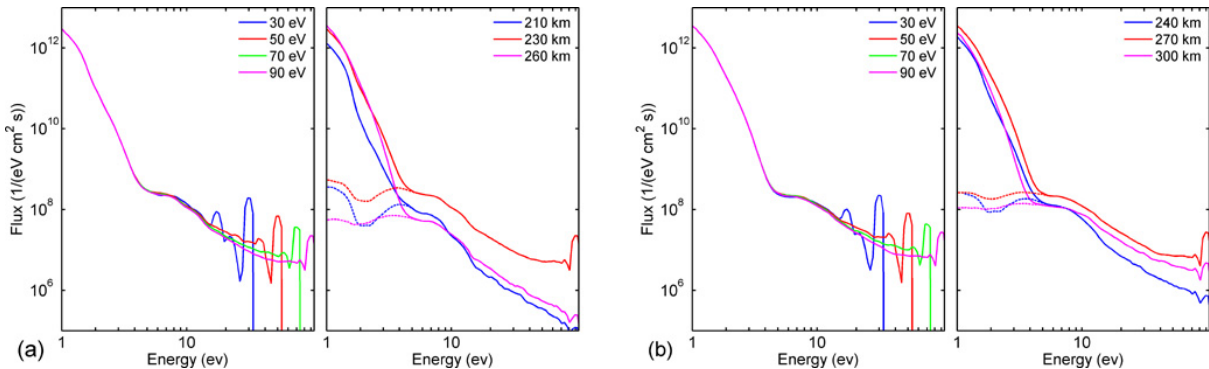
Fig. 6. (a) The energy dependence of the electron differential flux for the heating pulse at 18:12UT. Left: The differential fluxes for various energies of the accelerated electrons at the electron acceleration altitude (230km). Right: The electron differential fluxes at various altitudes calculated for the acceleration energy of 90eV. The dashed lines show the differential flux formed solely by the accelerated electrons; (b) same as panel (a) for the heating pulse at